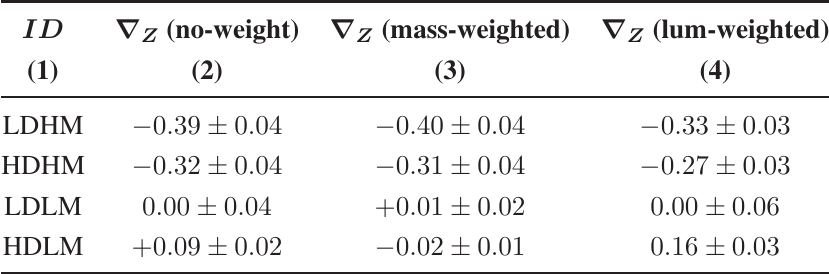
Table 2. Metallicity gradients of four ETG models in the radial range of 0 . 1 R Column 1 is the model ID label. Columns 2, 3, and 4, correspond to cases where the is computed with no-weight, mass-weight, and luminosity-weight assigned to each particle. Errors are the rms of estimates among 100 projections of each model. ∇ Z